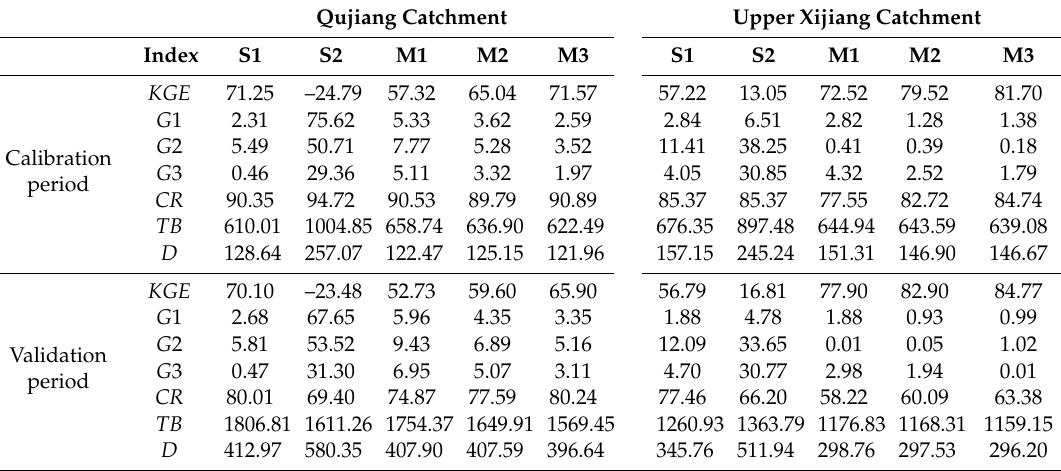
Table 4. Indexes for the e ffi ciency analysis of model-simulated Q that is calculated with the most likely parameter values, including the Kling-Gupta E ffi ciency KGE (%) and its components G 1(%), G 2(%), and G 3(%), and indexes for 90% confidence limits of total predictive uncertainty for Q (m 3 / s), including the Containing Ratio CR (%), the Transformed Average Bandwidth TB (m 3 / s), and the Average Deviation Amplitude D (m 3 / s) for multiple scenarios (single objective S1–S2, multi-objective M1–M3) in calibration and validation periods for the Qujiang catchment and the Upper Xijiang